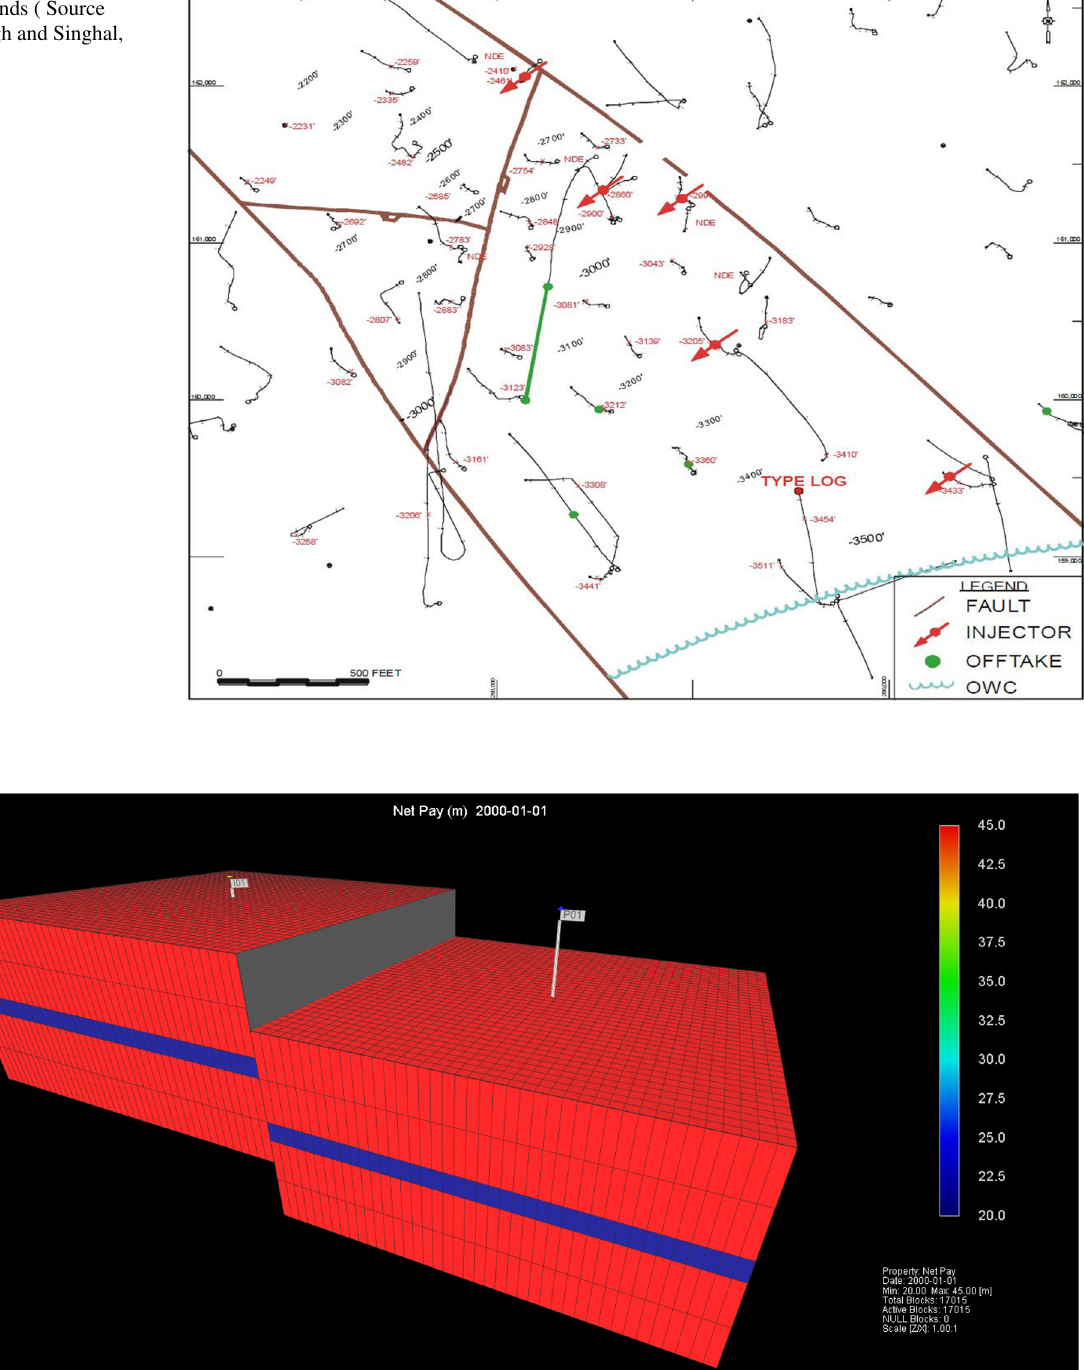
Fig. 9 Structure contour map